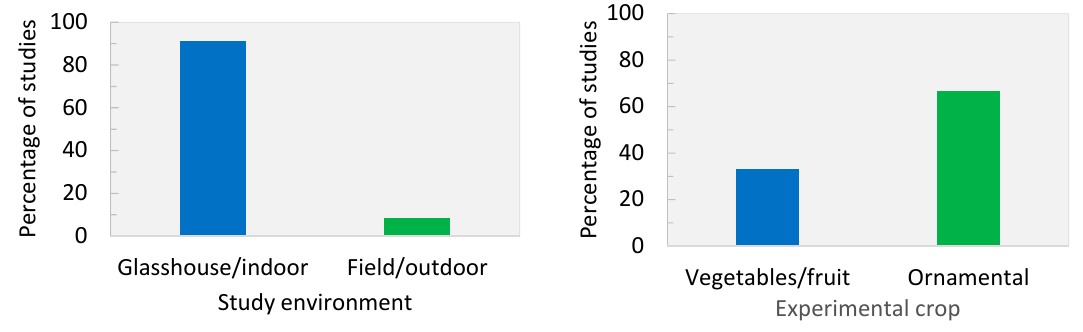
Figure 2. Distribution of studies based on the study environment ( left ) and experimental crop ( right